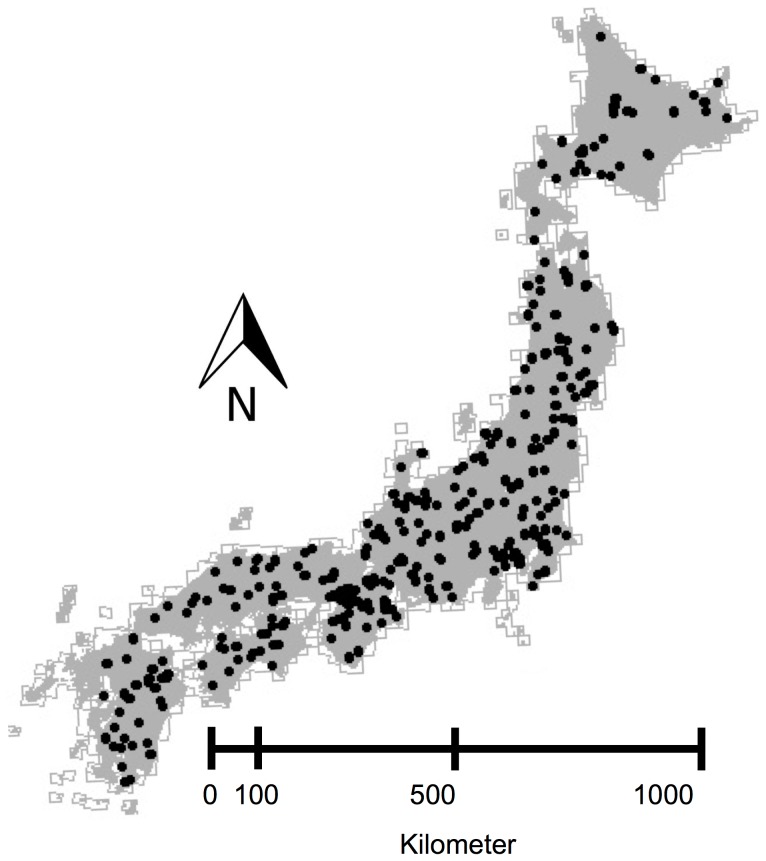
Locations of 313 study transects across the main four islands of Japan.